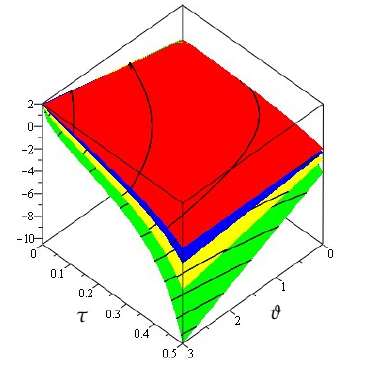
Figure 18. The different fractional-order of (cid:36) of ν ( ϑ , ζ , z , τ ) of Example